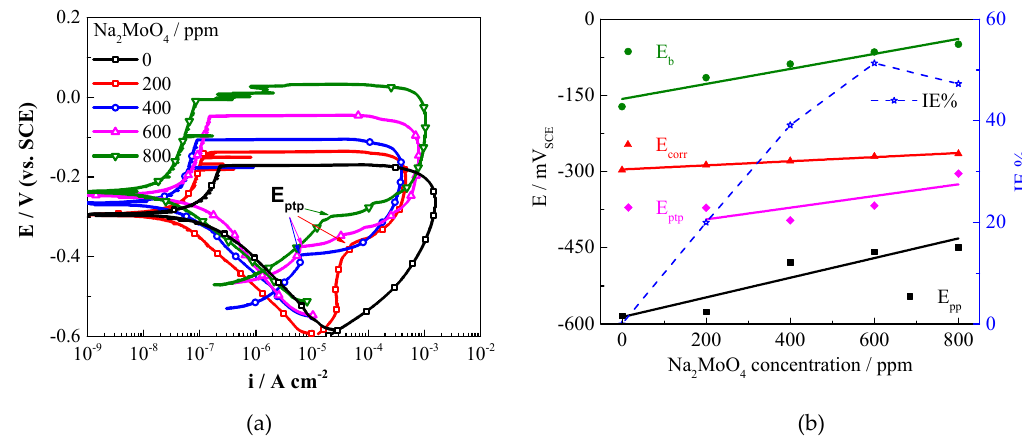
Figure 2. ( a ) Polarization curves of Q235 carbon steel in SCP solutions with various concentrations of Na 2 MoO 4 ; ( b ) The electrochemical parameters based on the polarization curves.